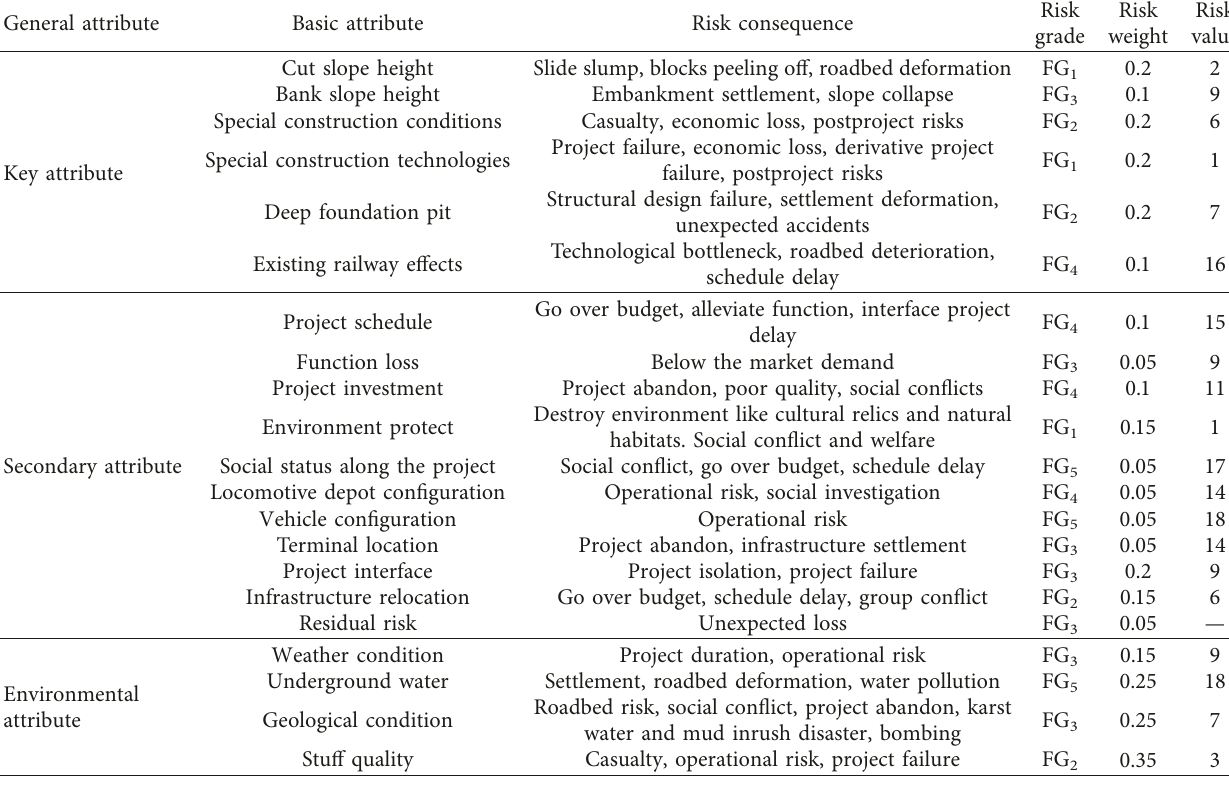
Table 1: Railway project accident risk analysis and evident definition.